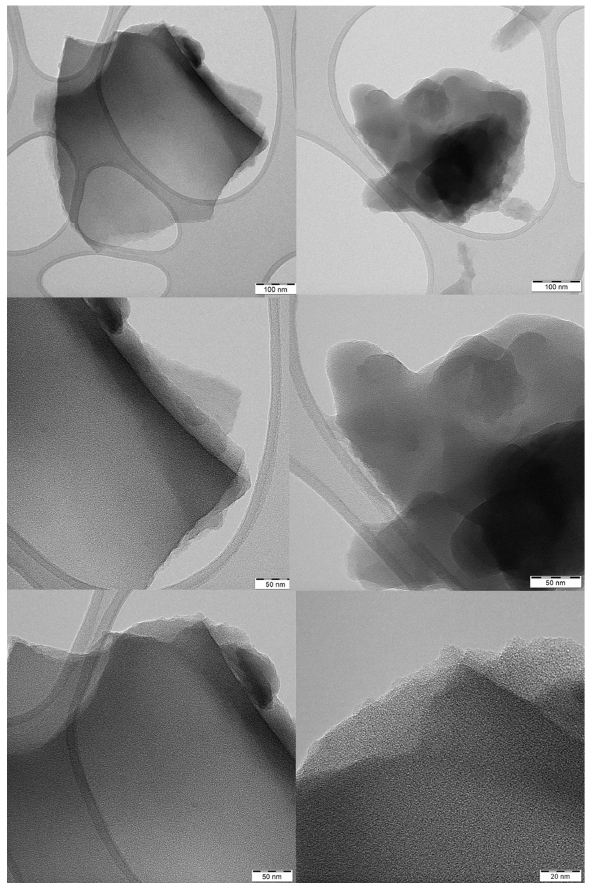
Figure 6. Representative transmission electron microscopy (TEM) micrographs of carbon nanosheets. The micrographs show some individual sheets along with their edge morphology. High-resolution transmission electron microscopy (HRTEM) chemical mapping shows an even distribution of the XPS-detected C, N, and O elements in the sample (Fig- ure 7). All elements are uniformly distributed over the surface of the carbon matrix, thus ensuring a homogeneous composition within the sample.